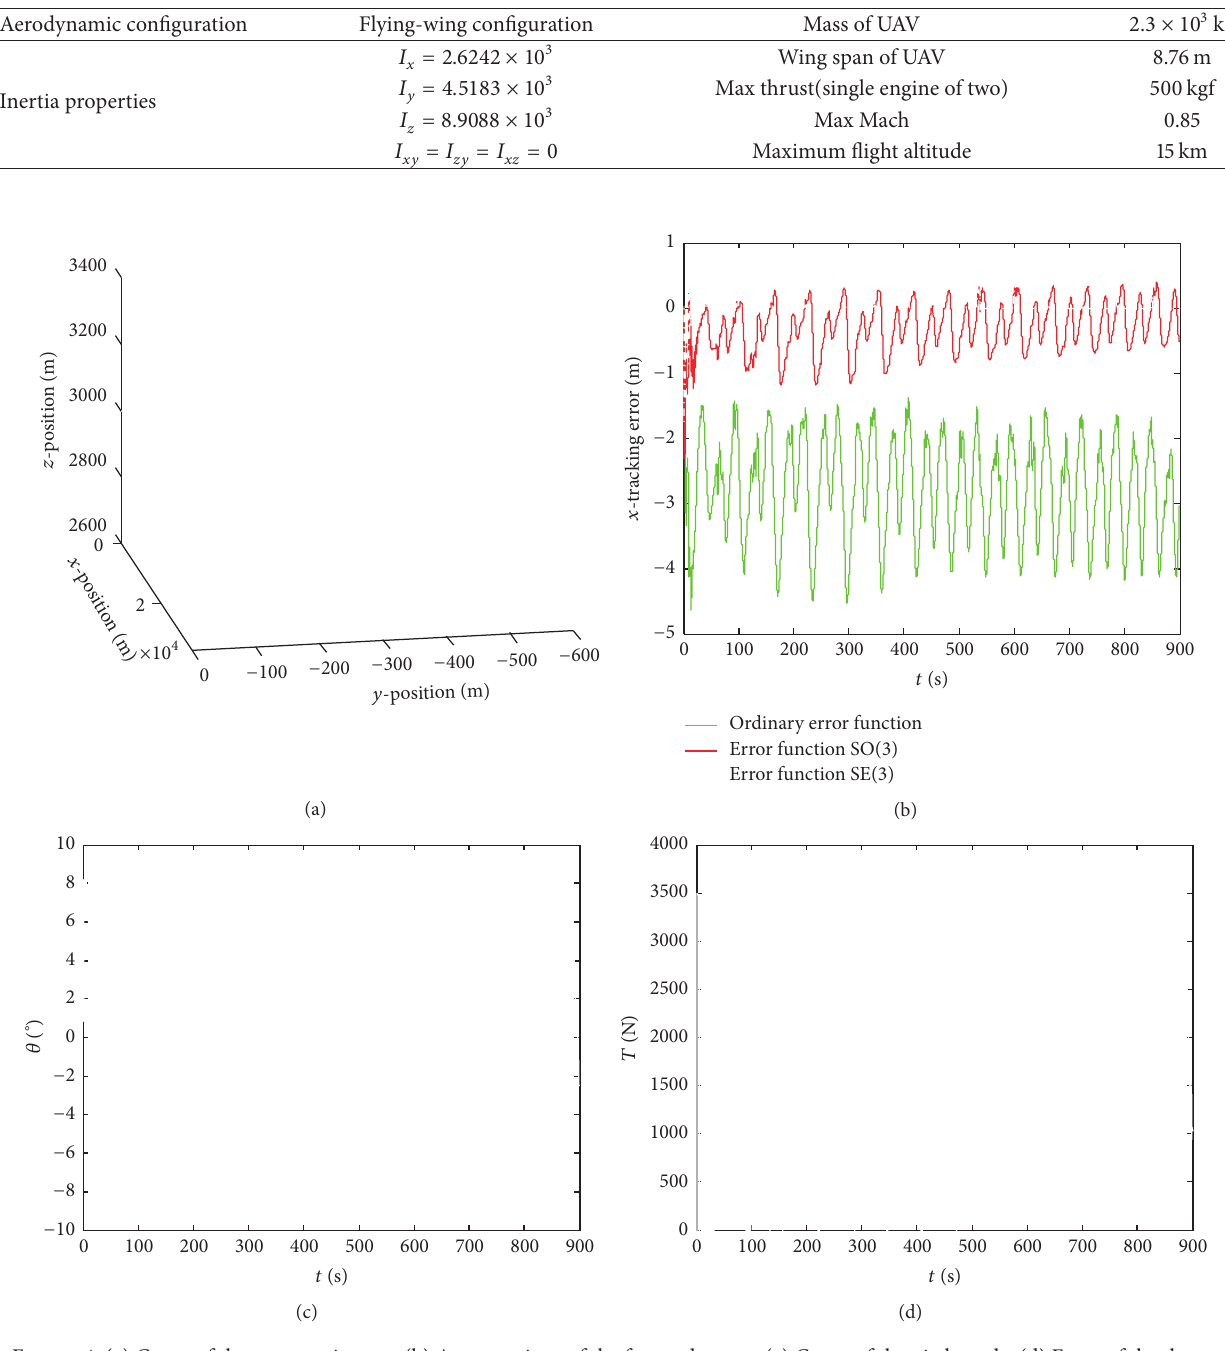
The target trajectory is chosen as an elliptic cylinder helix extending along the horizontal direction. The expression